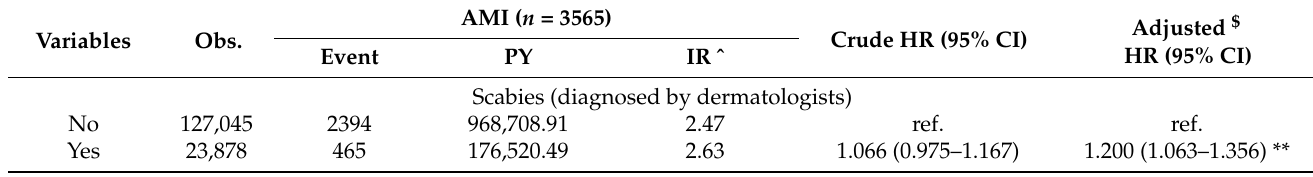
Table 5. Sensitivity analysis for the risk of AMI between scabies and non-scabies groups.